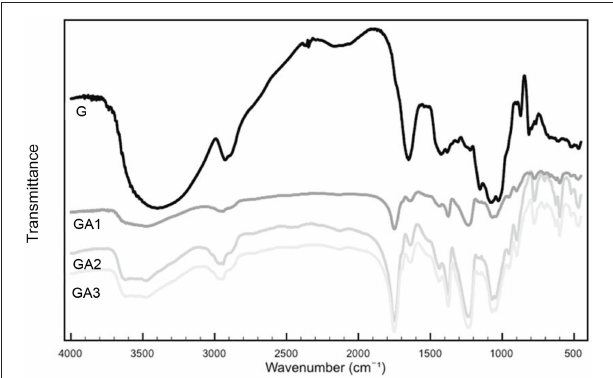
FIGURE 1 | Fourier transform infrared spectra in the spectral region of 400 and 4,000 cm − 1 of unmodified galactomannan (G) and galactomannan acetate treated with 10mL (GA1), 20mL (GA2), and 30mL (GA3) of acetic anhydride. Two replicates were performed for each sample.